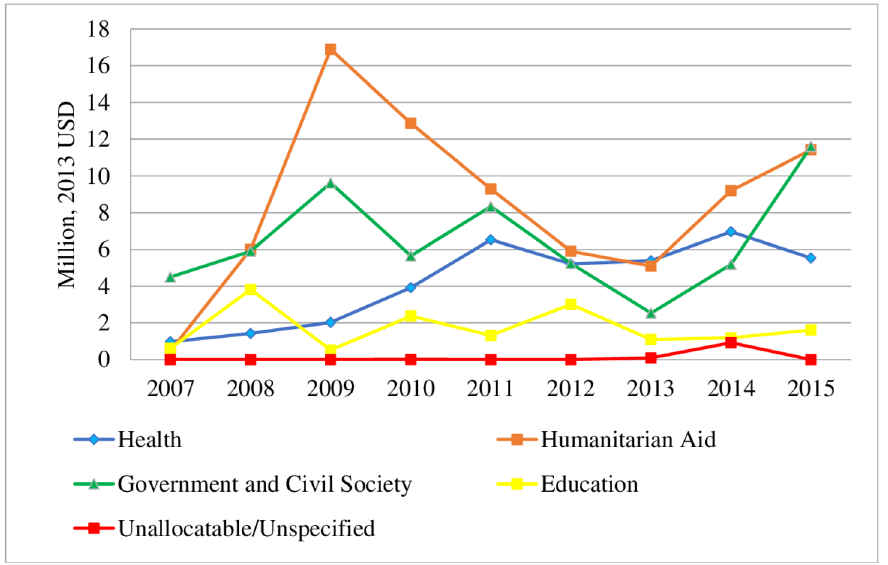
Fig 2. DAMH_CA by year and sector (million, 2013 USD), lower-bound estimates. In this figure, we combined the sectors “General Health” and “Population Program and Reproductive Health” in the original CRS dataset as “Health,” the sectors “Humanitarian Aid” and “Multisector/Crosscutting” as “Humanitarian Aid,” and the sectors “Government and Civil Society” and “Other Social Infrastructure and Services” as “Government and Civil Society.” CRS, Creditor Reporting System; DAMH_CA, development assistance for child and adolescent mental health; USD, US dollar.